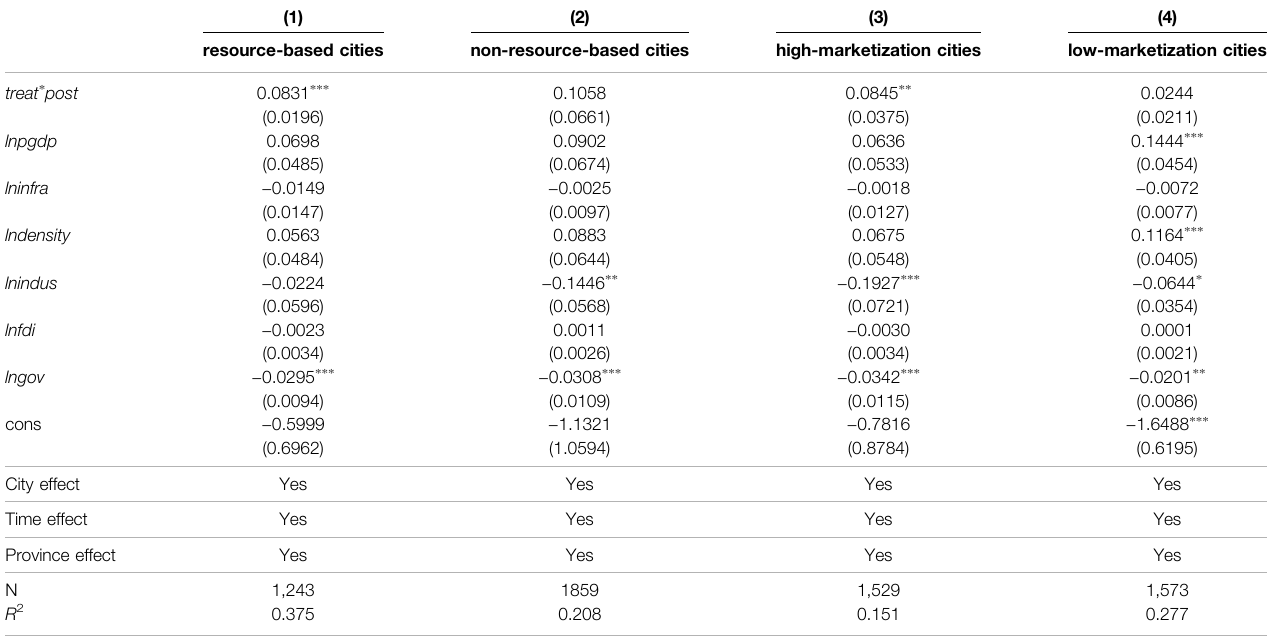
TABLE 6 | The results of heterogeneity